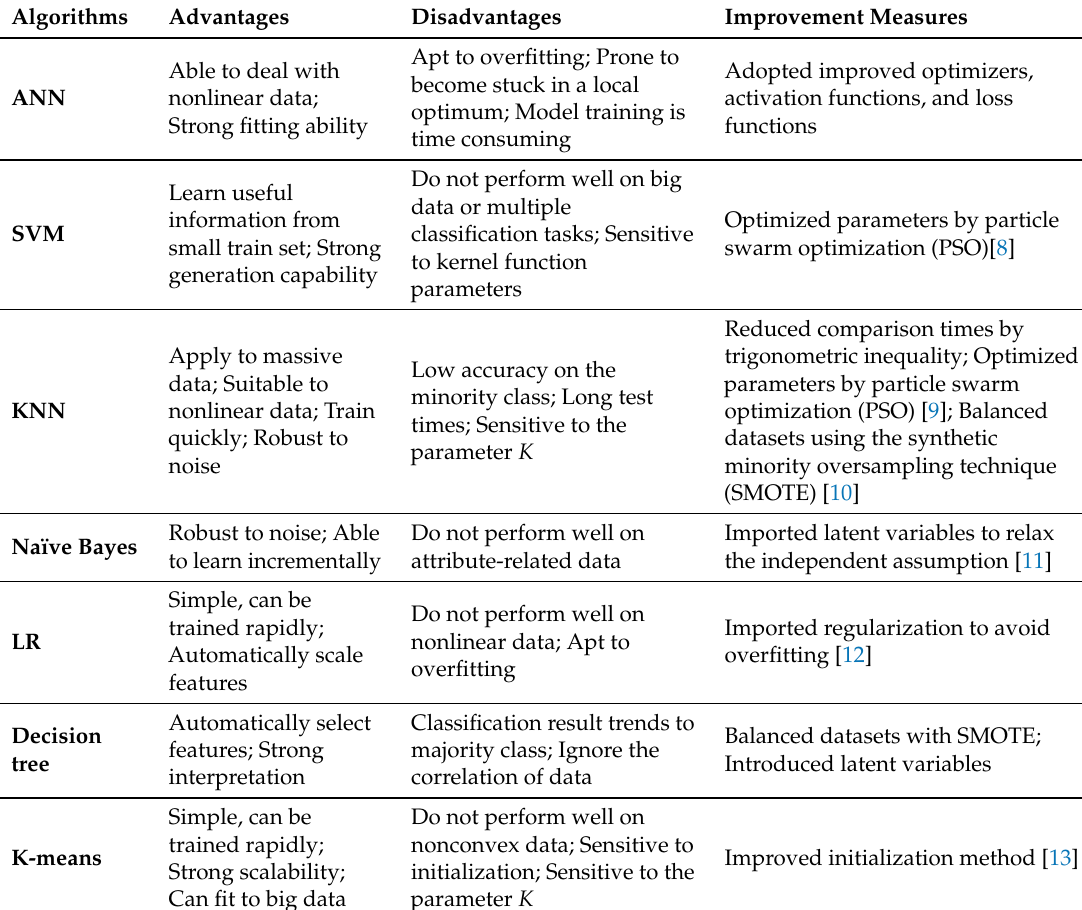
Table 3. The pros and cons of various shallow